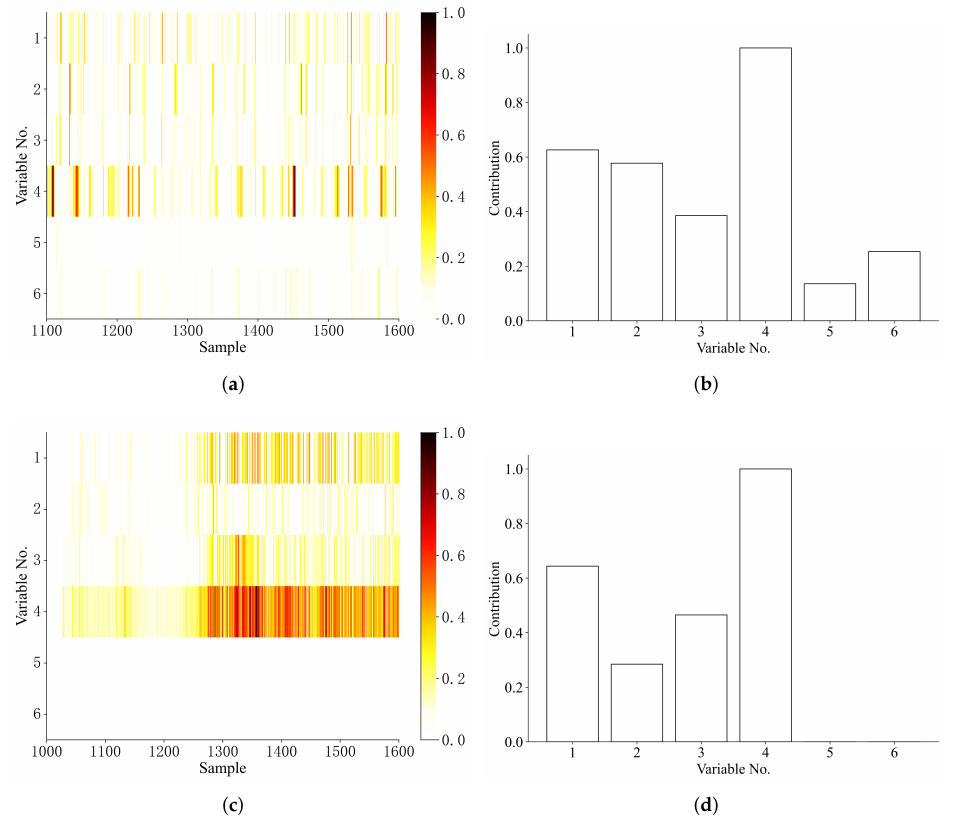
Figure 4. Fault isolation results for the CSTR process ( a ) BRNN with LDR isolation ( b ) BRNN with LDR contribution ( c ) Wasserstein distance isolation ( d ) Wasserstein distance